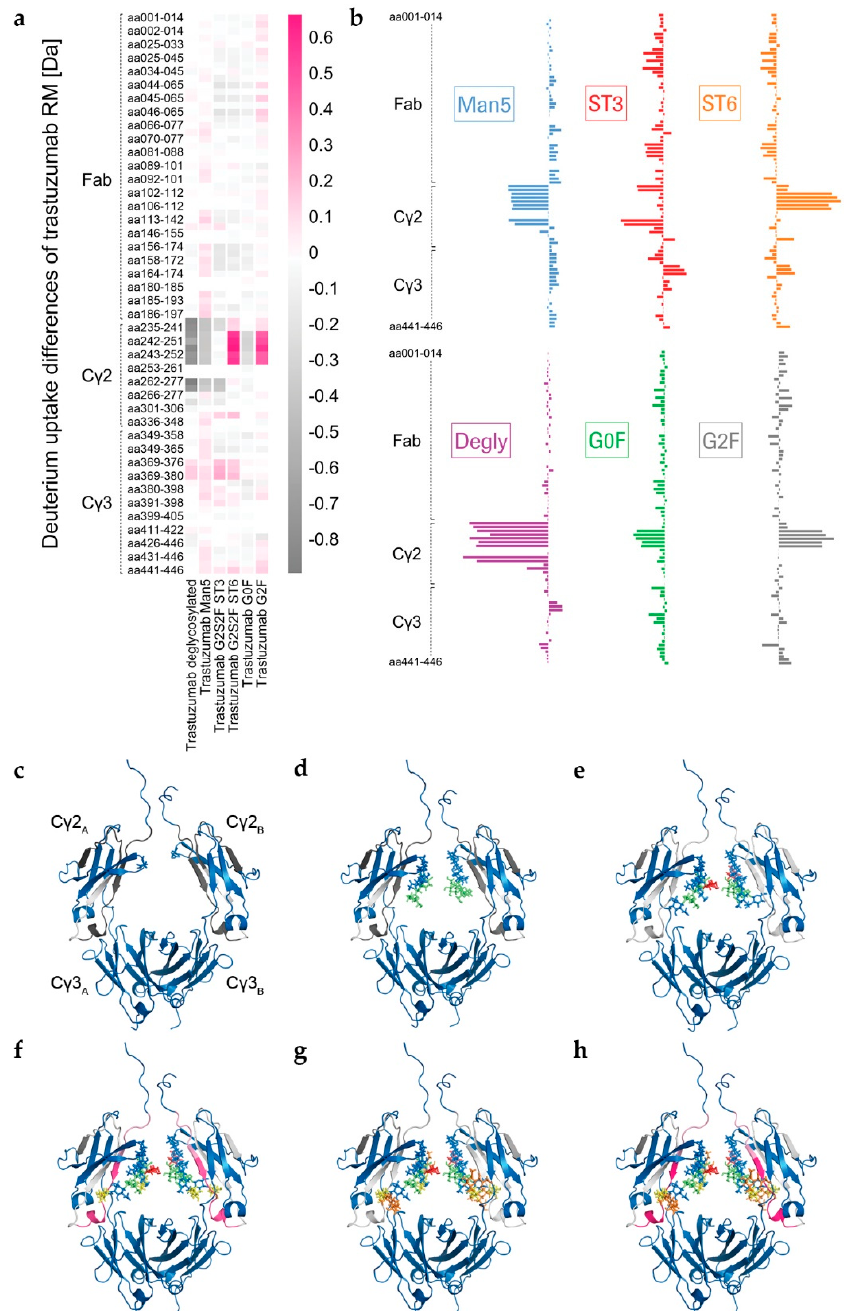
Figure 2. Average deuterium (D) uptake differences (Da) of trastuzumab reference material (RM) and glyco-engineered trastuzumab variants ( n = 6) after 10 min of H/DX. ( a ) Differential heat map and ( b ) uptake plot of (shared) trastuzumab heavy chain peptides, resulting from pepsin/type XIII digestion (sequence coverage 87%–94%). ( c – h ) Differential D, uptake as established in ( a ) and projected onto Fc crystal structures based on PDB ID code 5VGP: ( c ) “Degly”, ( d ) “Man5”, ( e ) “G0F”, ( f ) “G2F”, ( g ) “ST3”, and ( h ) “ST6”.